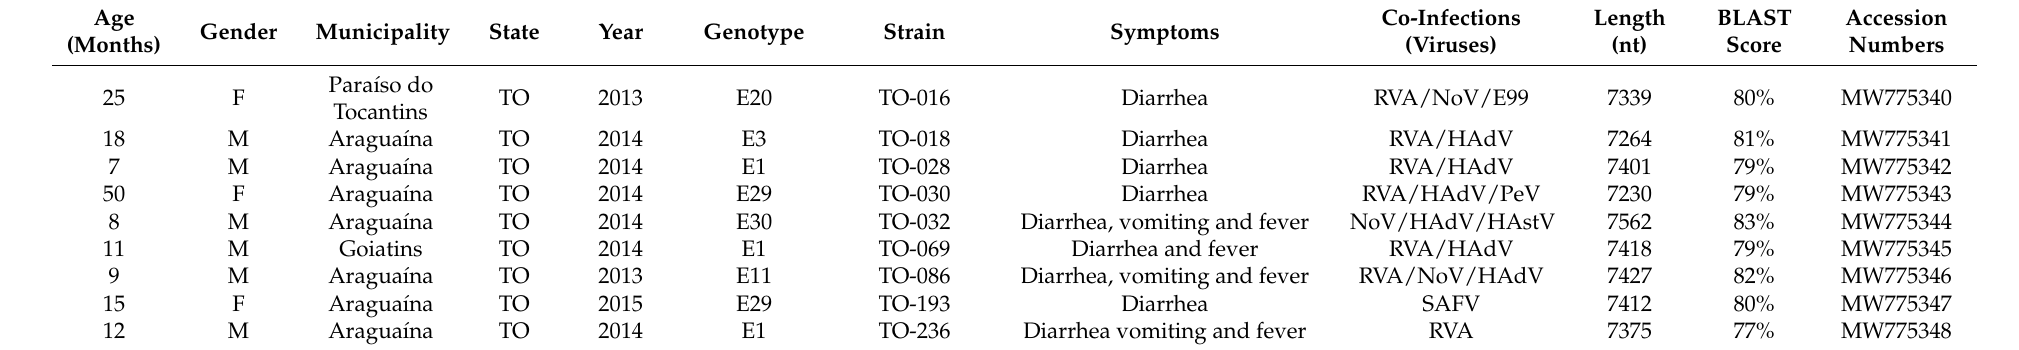
Table 1. Socio-demographic and molecular data of positive echovirus samples from patients with acute gastroenteritis in Northern